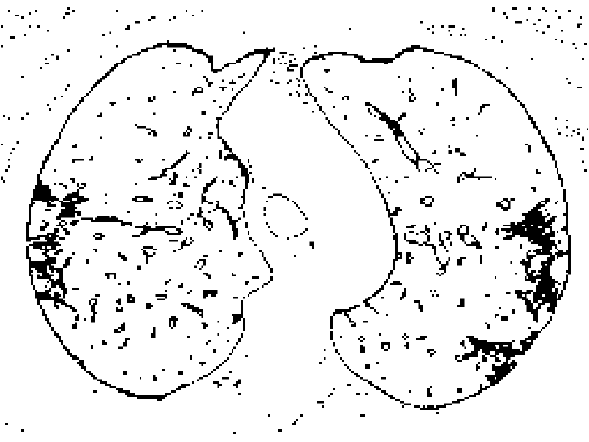
Figure 2. Region analysis of thresholding image as a binary file (positive COVID scan).